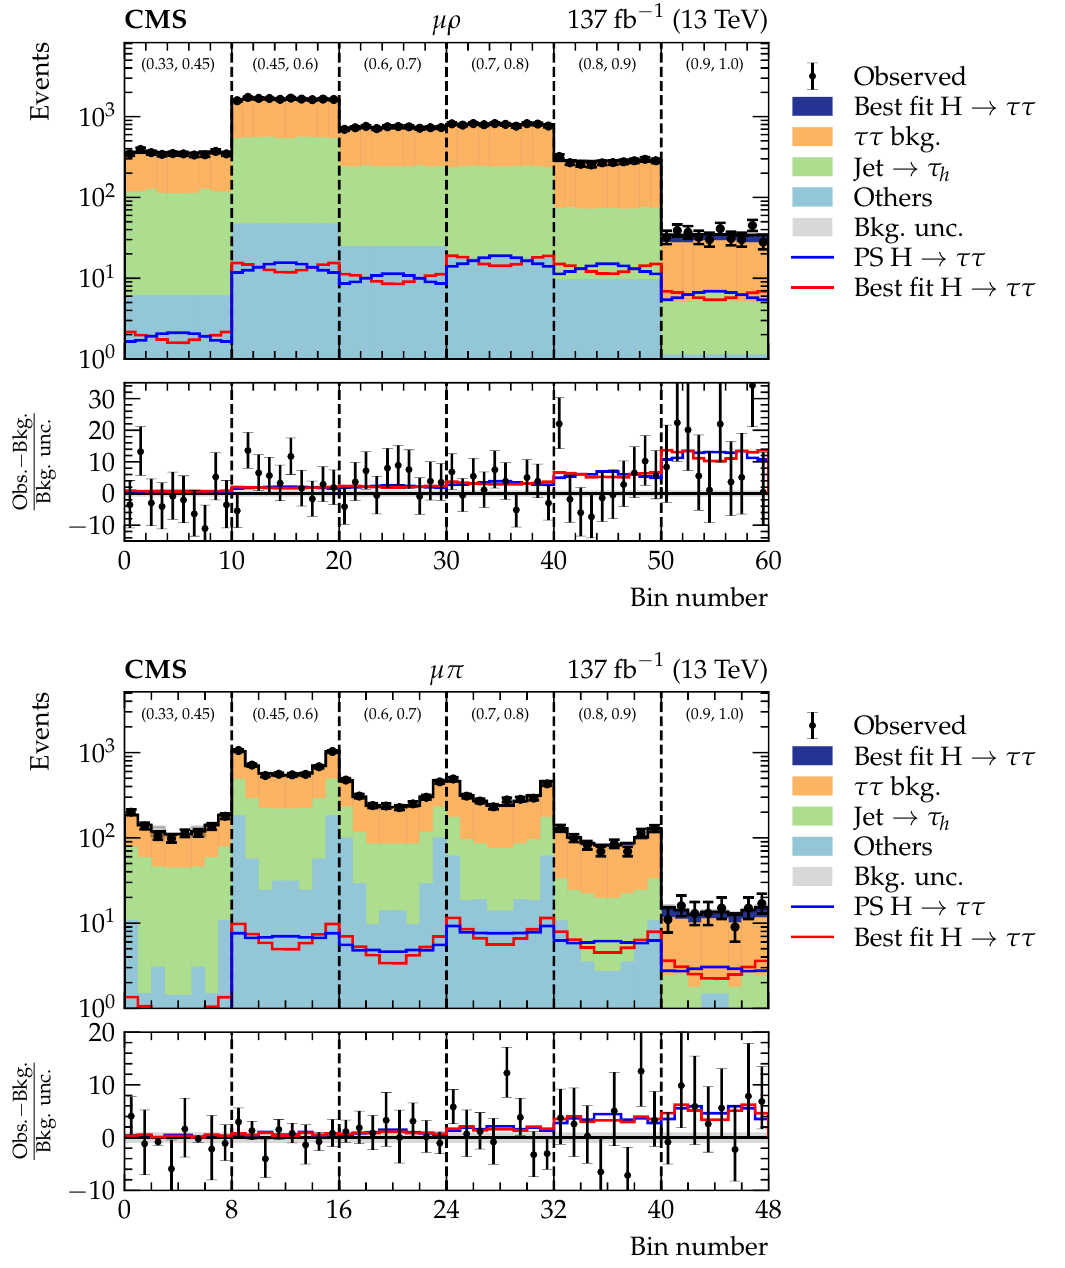
in the mr (upper) and mp (lower) channels in windows of increasing Figure 8 . Distributions of φ CP MVA score, shown on top of each window. The best fit and pseudoscalar (PS) signal distributions are overlaid, where in both cases the signal cross sections are set to the values obtained from the fit to data, which are given in section 12.1. The x -axis represents the cyclic bins in φ in the CP range of (0 , 360 ◦ ) . In the lower panels, the data minus the background template divided by the uncertainty in the background template is displayed, as well as the signal distributions divided by the uncertainty in the background template. The uncertainty band accounts for all sources of systematic uncertainty in the background prediction, after the fit to